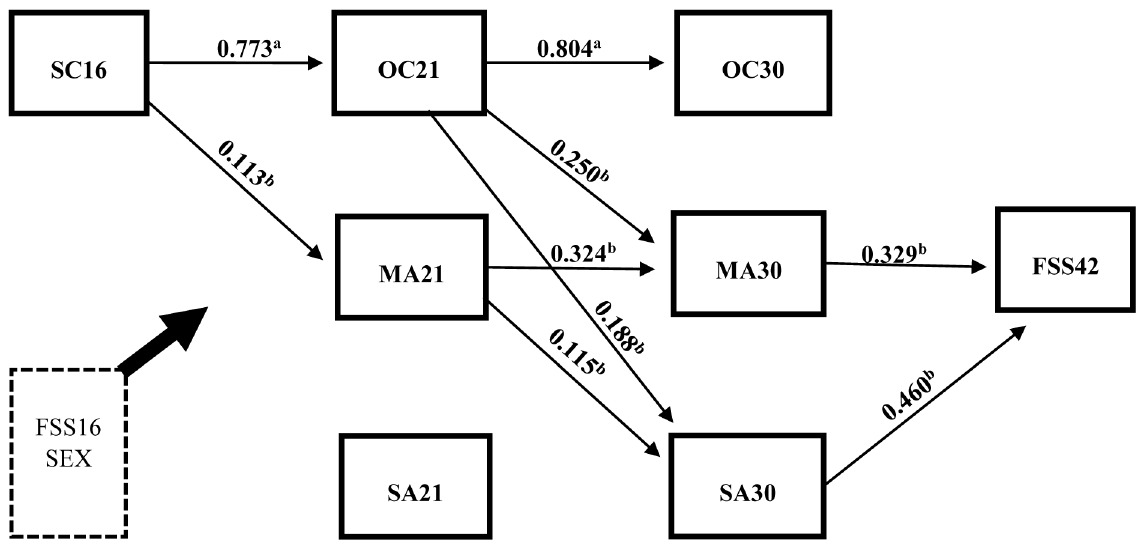
Fig 3. Significant (p < 0.001) path coefficients in the model estimated with respect to the full sample (n = 987) while controlling for sex and baseline functional somatic symptoms. a Predictor estimates are probit regression coefficients. b Predictor estimates are unstandardized regression coefficients